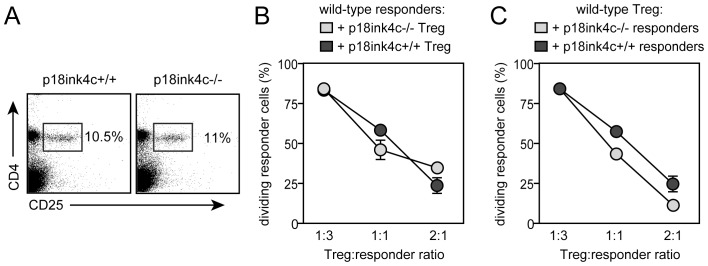
Frequency and function of regulatory T cells from p18ink4c−/− mice.Spleens from naïve, 4-week-old WT (left panel) and p18ink4c−/− (right panel) mice were stained for CD4 and CD25 to identify Treg (A). CFSE-labeled CD4+CD25− conventional T cells purified from wild-type mice were used as targets for CD4+CD25+ Treg purified from either WT (dark gray bars) or p18ink4c−/− (light gray bars) mice in a standard anti-CD3-stimulated suppression assay (B). CFSE-labeled CD4+CD25− conventional T cells purified from either WT (dark gray bars) or p18ink4c−/− (light gray bars) mice were used as targets for wild-type CD4+CD25+ Treg (C). Data are plotted as the mean +/−SD of triplicate cultures.